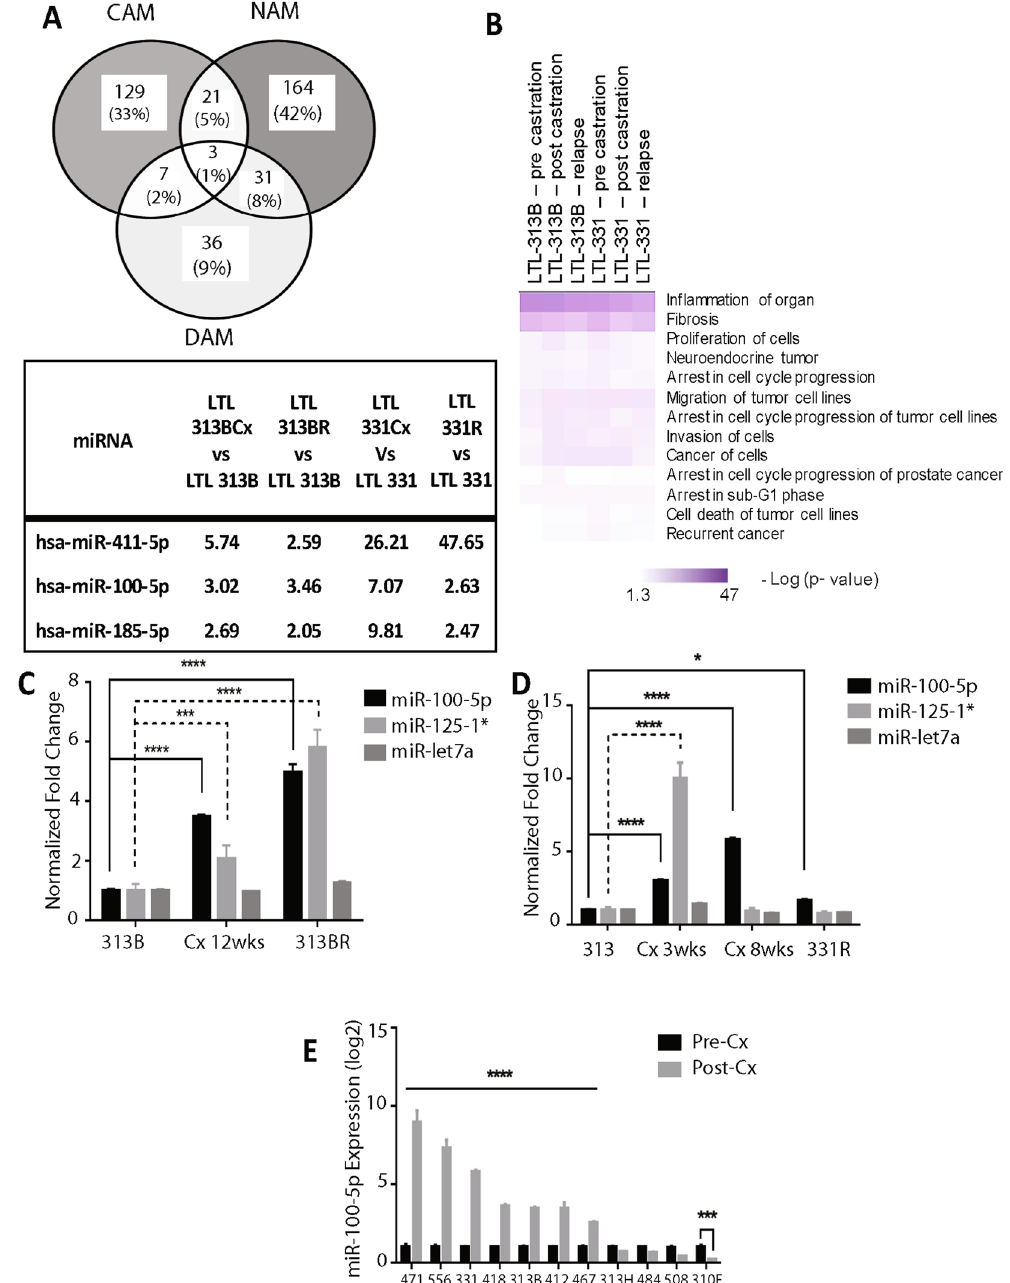
Figure 2. MicroRNAome profiling reveals pathways associated with prostate cancer biology and identifies miR-100-5p association with ADT. ( A ) Identification of candidate miRNAs that were up-regulated during the post-castration period and in both CRPC/NEPC relapses. microRNA-specific microarray was performed on hormone-naive (LTL-313B/-331), post-castrated (LTL-313BCx/-331Cx), and relapse (LTL-313BR/- 331R) in PCa PDX progression models for CRPC and NEPC, respectively. microRNAs with a fold change of > 2.0 compared to LTL-313B/-331 were identified as being up-regulated for post-castration in both models (dormancy-associated microRNAs; DAM), CRPC relapse (CRPC-associated microRNAs; CAM), or NEPC relapse (NEPC-associated microRNAs; NAM). microRNAs that were specifically up-regulated during the post-castration period and in both relapses were determined by overlapping DAM, CAM, and NAMs. ( B ) Top representative canonical pathways associated with LTL-313B and LTL-331 PDX models. microRNA microarray analysis of hormone sensitive and insensitive PDX models reveals miR-100-5p being consistently expressed, and upregulated in both CRPC (LTL-313B) and NEPC (LTL-331) fated tumors post therapy. ( C , D ) miR-100-5p is upregulated in vivo upon androgen ablation (host castration) in both CRPC and NEPC fated tumors. Mature microRNA expression from the MIR100HG cluster are also evaluated in LTL-313B/-331 castration (Cx) series (pre-Cx, post-Cx, relapse) via qPCR. ( E ) miR-100-5p expression was measured in 11 representative pre- and post-Cx PCa PDX models via